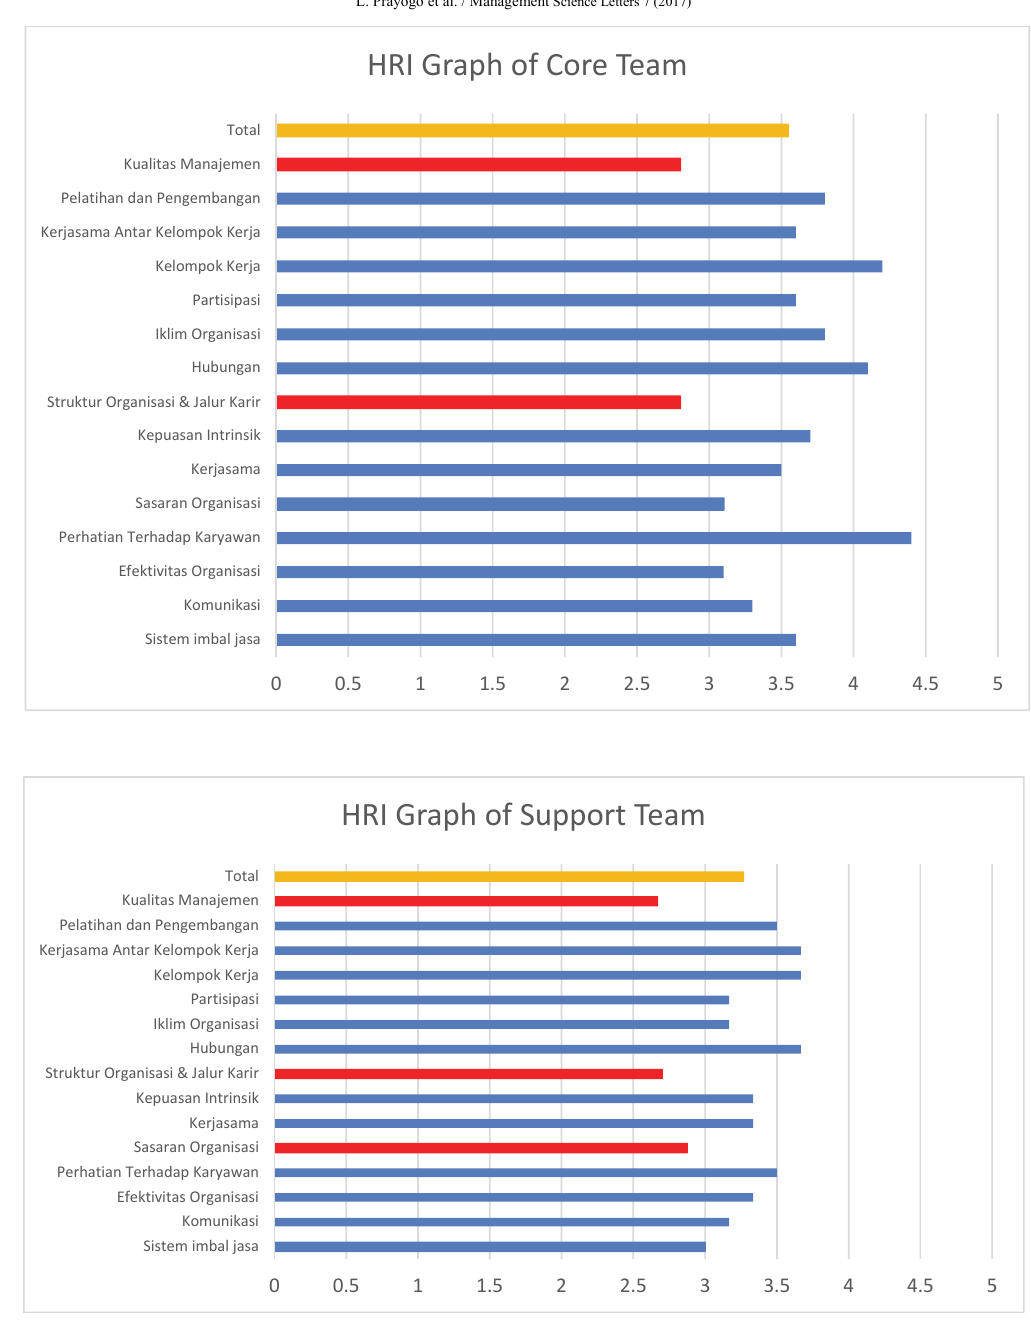
Fig. 4. HRI Graph of Core Team and Support